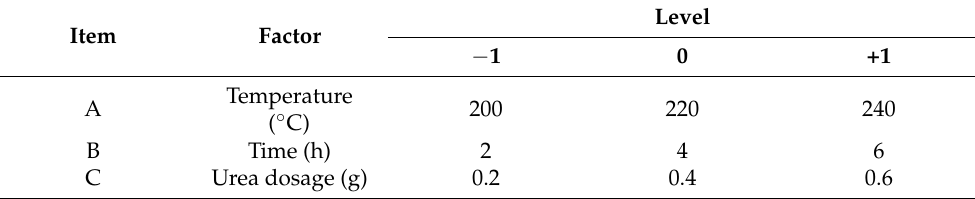
Table 3. Box–Behnken experimental factors and levels design for optimizing preparation conditions of N-CQDs